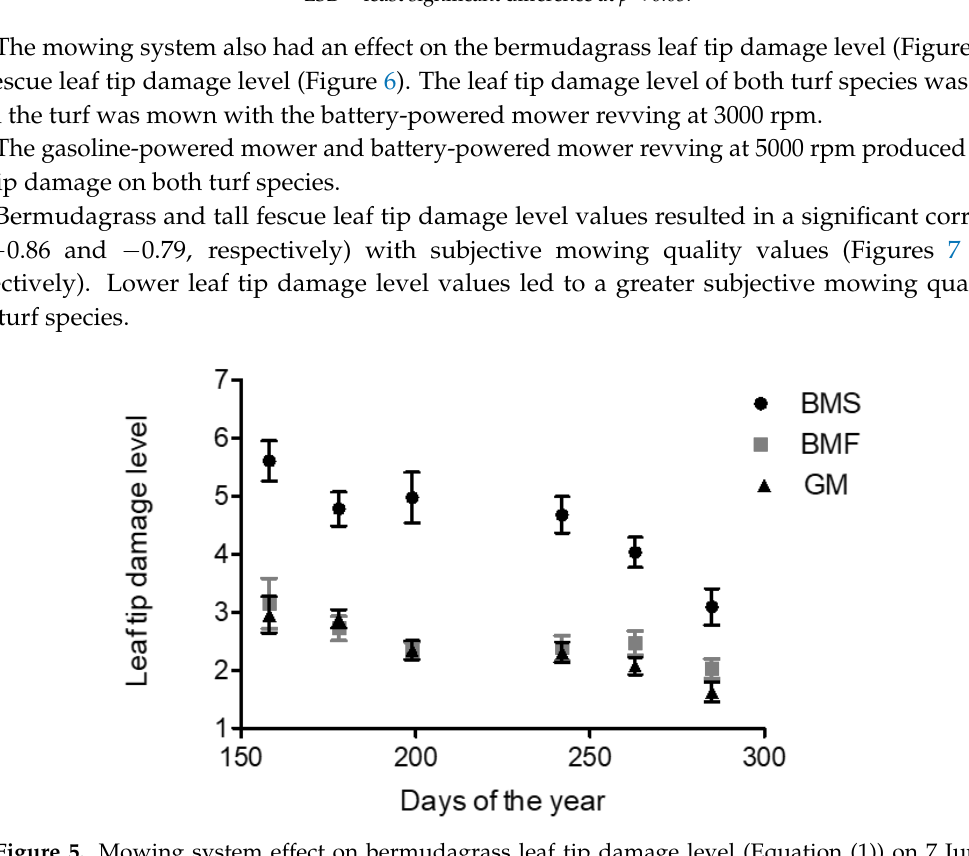
Figure 5. Mowing system effect on bermudagrass leaf tip damage level (Equation (1)) on 7 June, 27 June, 18 July, 30 August, 20 September and 12 October. BMS = battery-powered mower revving at 3000 rpm, BMF = battery-powered mower revving at 5000 rpm and GM = gasoline-powered mower. Letters “a” and “b” indicate statistically different values at p < 0.05 for each assessment date.